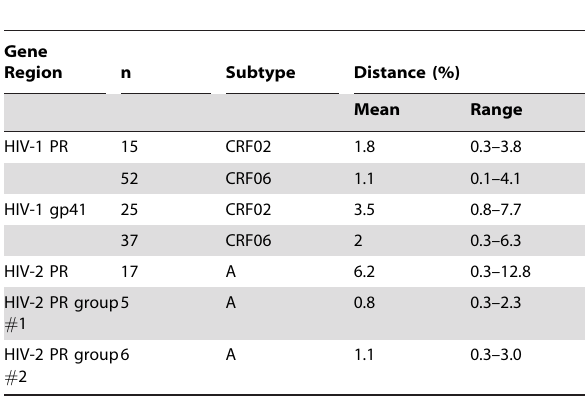
Table 2. Genetic distances within HIV subtypes and CRFs.